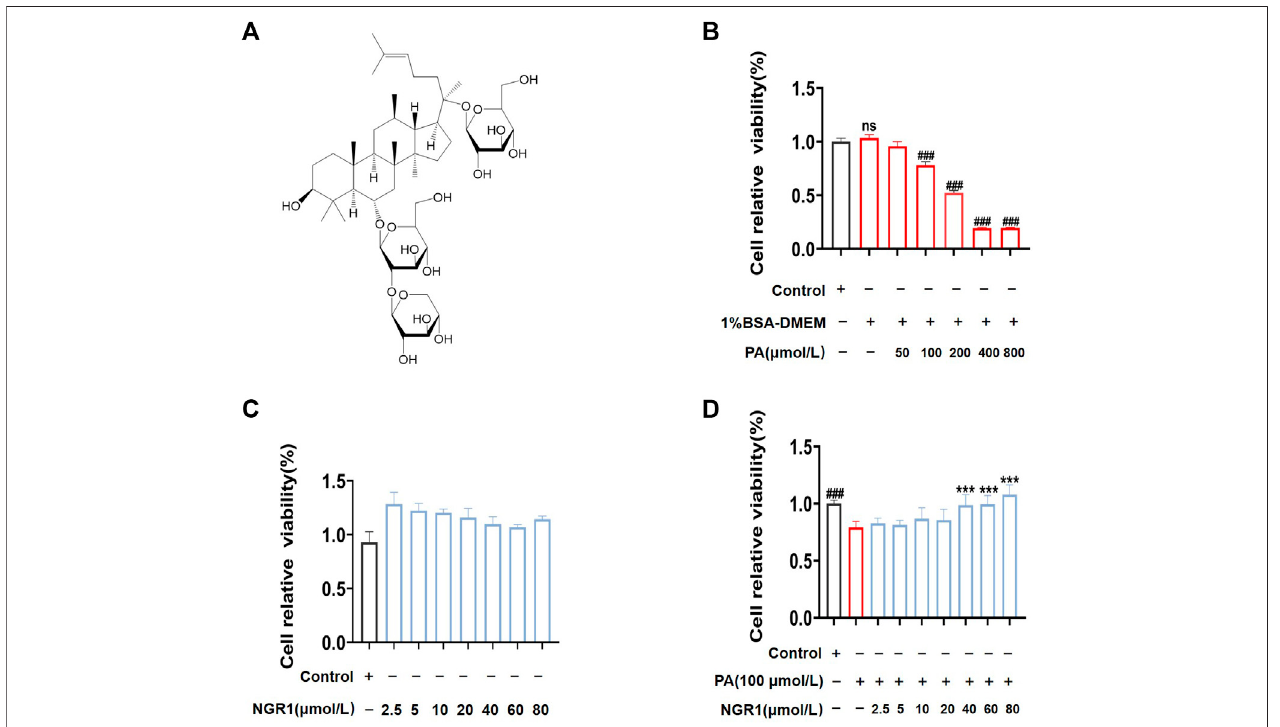
FIGURE 4 | NGR1 increased the survival rate in PA-induced lipotoxicity H9C2 cell model. (A) Chemical structure formula of NGR1 (B) PA reduced cell viability in a concentration-dependentmannerbyCCK-8 assay. (C) H9C2cellswereincubated withdifferentdosage(2.5 μ mol/Lto80 μ mol/L)ofNGR1for24 h.CCK-8assaywas usedtodetectcellviability. (D) Cellswereco-incubatedwithNGR1(dosefrom2.5 μ mol/Lto80 μ mol/L)andPA(100 μ mol/L)for24 h,thencellviabilityweredetectedby CCK-8 assay. *** p < 0.001 vs. model group, ### p < 0.001 vs. control group, ns stands for not statistically signi fi cant, repeat the experiment three times